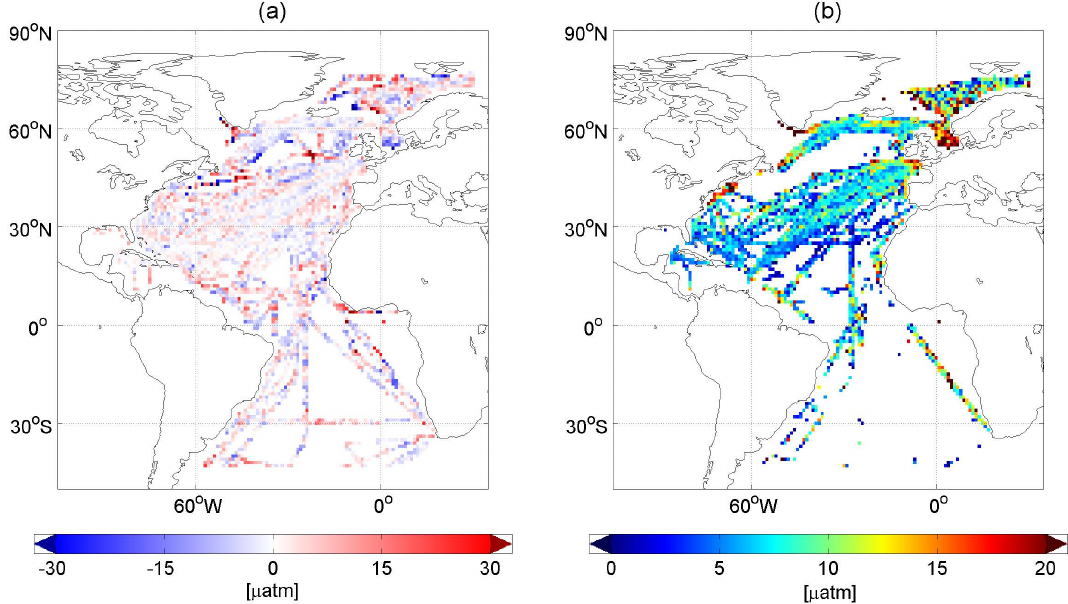
Fig. 2. (a) Temporal mean residuals and (b) standard deviation of the residuals inµatm between neural network estimates and SOCAT v1.5 gridded observations (Sabine et al., 2013) for the period from 1998 to 2007. Pixels that have a value in (a) but not in (b) indicate where only 1 observation in time is